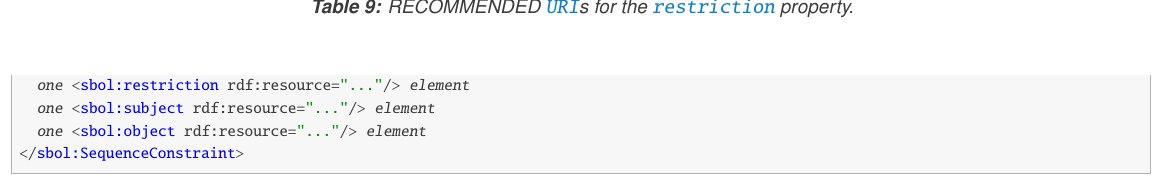
Table 9: RECOMMENDED URI s for the restriction property.